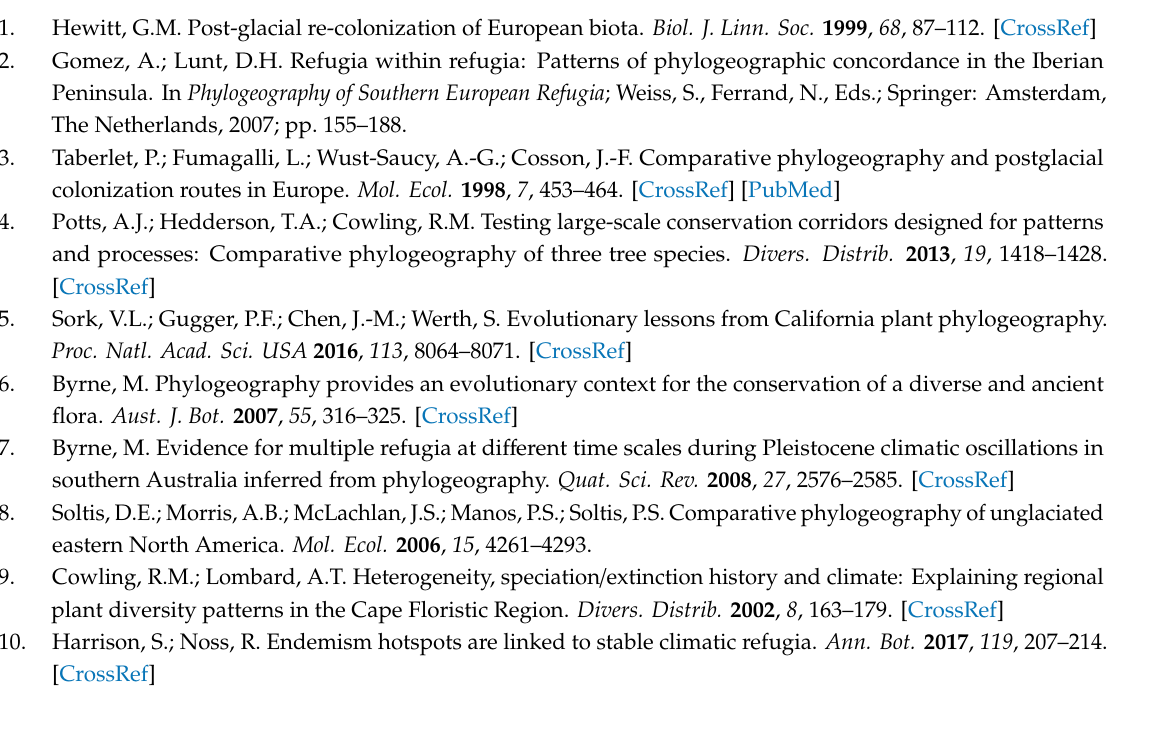
Table S1: Details for the populations of Corymbia hamersleyana ( n = 20) sampled across the Pilbara region of north-western Australia; Table S2: Details for the populations of Acacia pruinocarpa ( n = 23) sampled across the Pilbara region of north-western Australia; Table S3: Primer sequences and characteristics of microsatellite loci developed for Corymbia hamersleyana (CH) and Acacia pruinocarpa (AP); Table S4: Estimates of global F ST of Weir (1996) both using and without using the ENA correction described in Chapuis and Estoup (2007); Figure S1: Results of STRUCTURE analyses of C. hamersleyana showing Delta K vs. K and bar plots of individual assignment to clusters K = 2, 6, 8, 13, and 15; Figure S2: Results of STRUCTURE analysis of A. pruinocarpa showing Delta K vs. K and bar plots of individual assignment to clusters K = 2, 6, 8, 13, and 15; Figure S3: Principal co-ordinates analysis based on microsatellite data for individuals of A) Corymbia hamersleyana and B) Acacia pruinocarpa sampled across the Pilbara region of Western